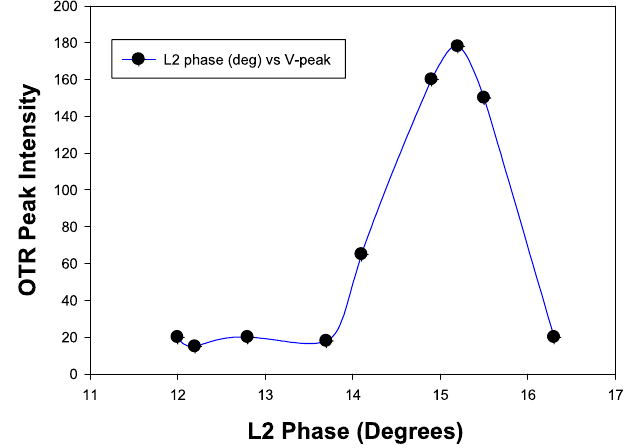
FIG. 6. (Color) Plot of the peak intensities from the OTR image vertical profiles taken near the enhanced regime coordinates as a function of L2 phase in degrees [11].